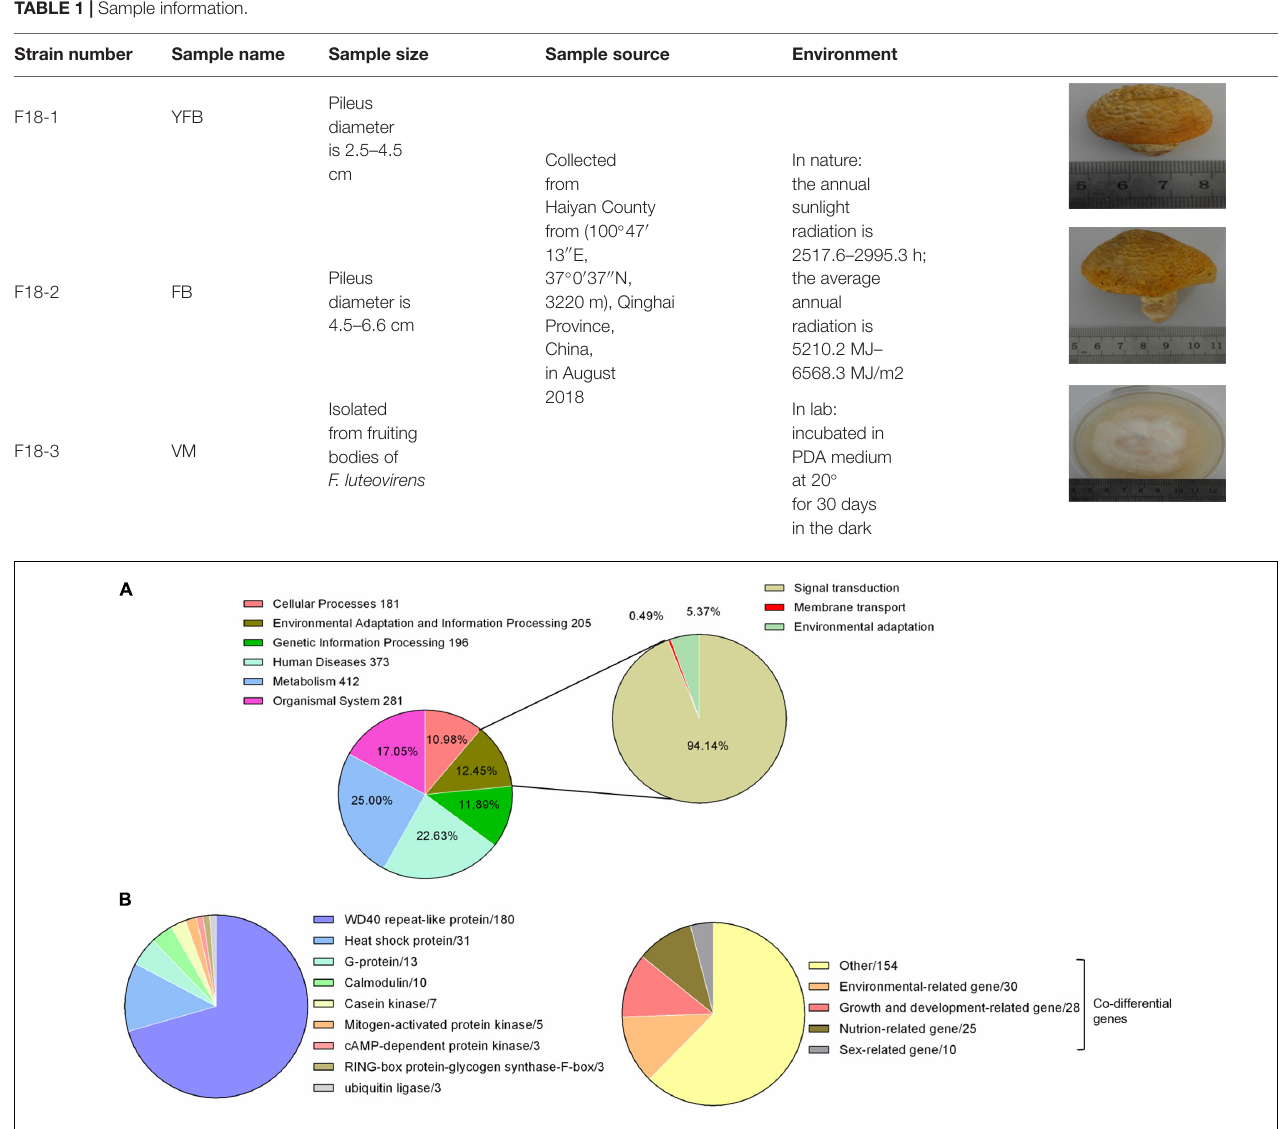
FIGURE 1 | Environmental related genes of F. luteovirens . A total of 205–225 genes involved in responding to environment. (A) Pie chart of the 205 environmental adaptation and information processing genes from genome. (B) Pie chart of the 225 environmental related genes from transcriptome [The 225 genes = DEGs (255) − Co differential genes of environmental-related